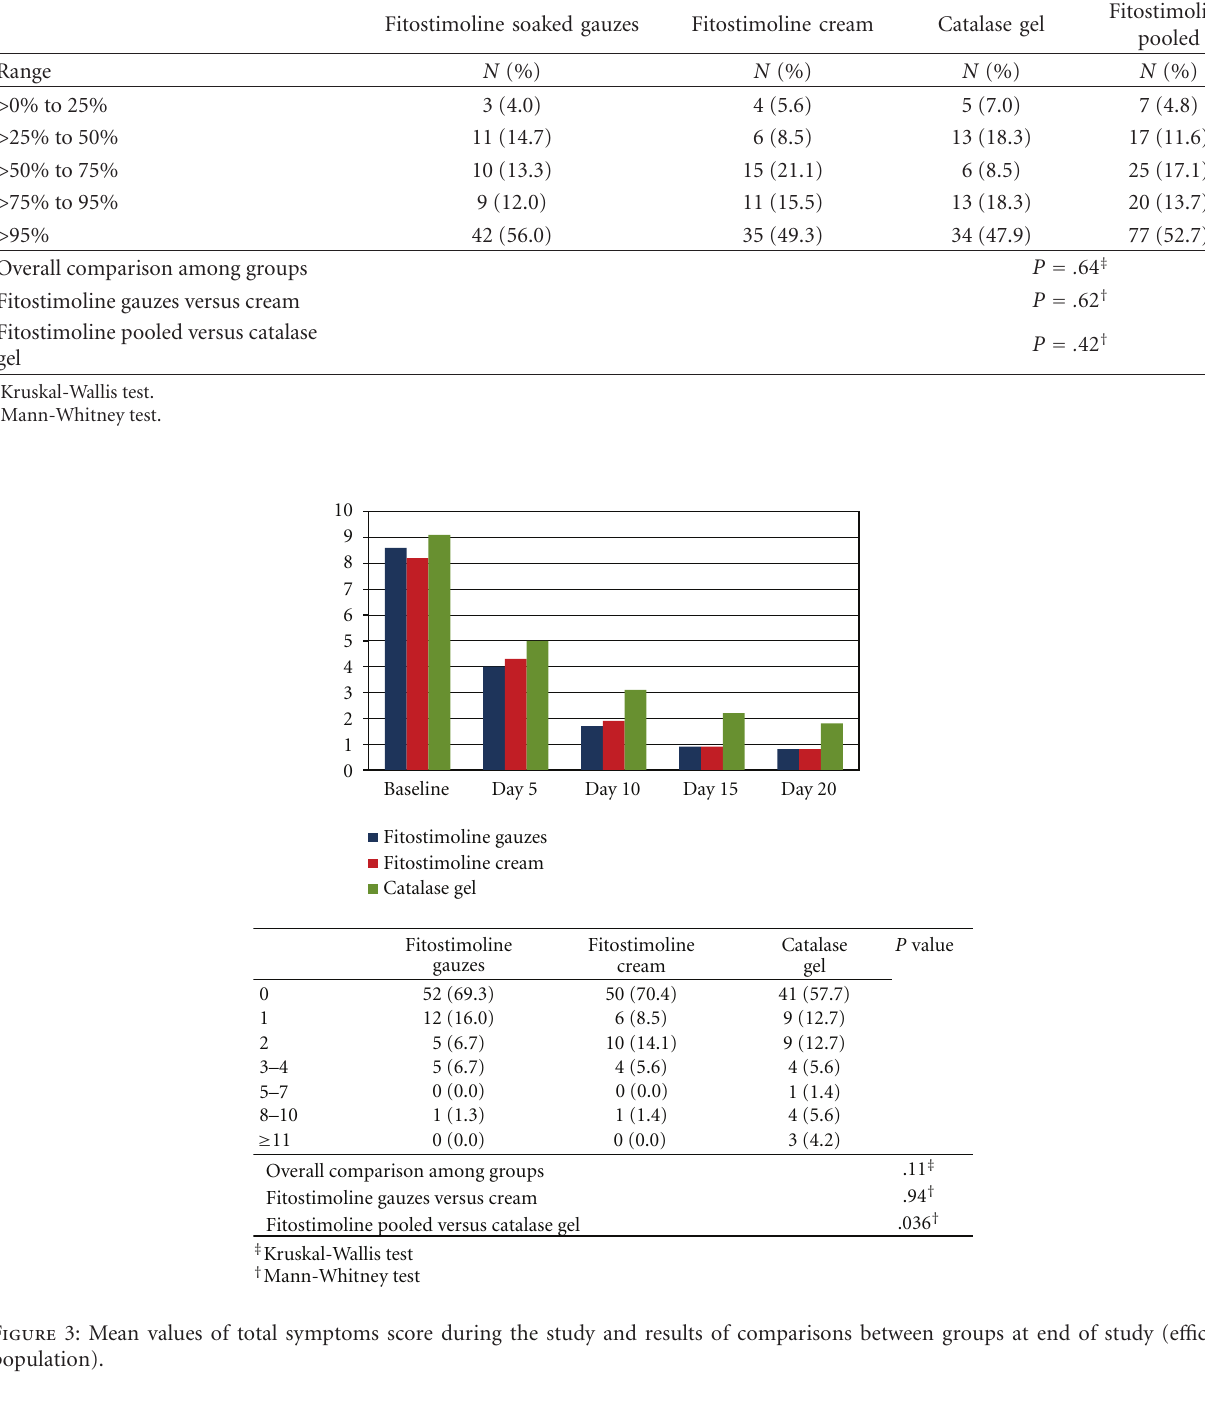
Table 3: Reepithelialisation at Day 10 (e ffi cacy population).